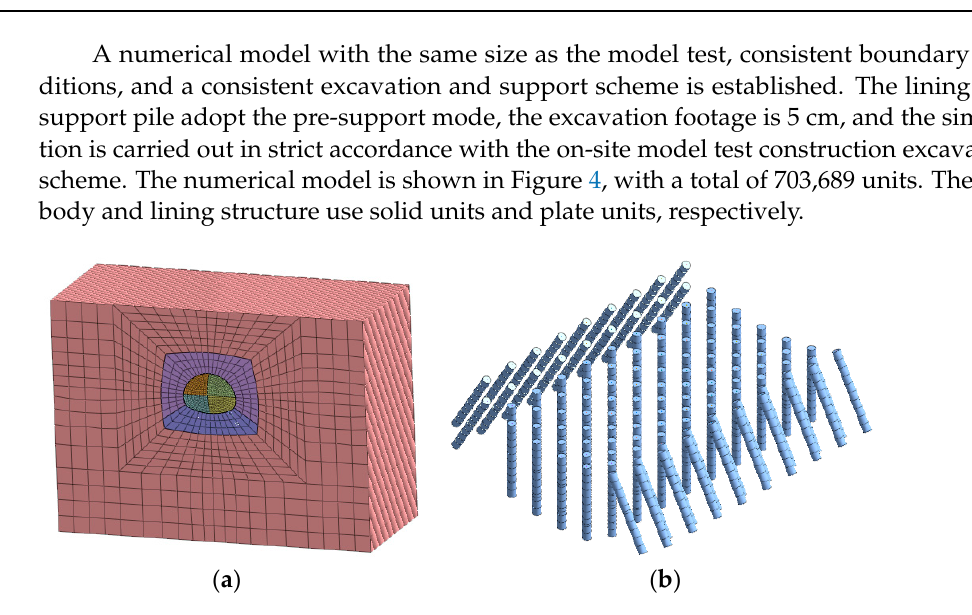
Figure 4. Finite element numerical model: ( a ) Computational model; ( b ) Rotary jet pile model.